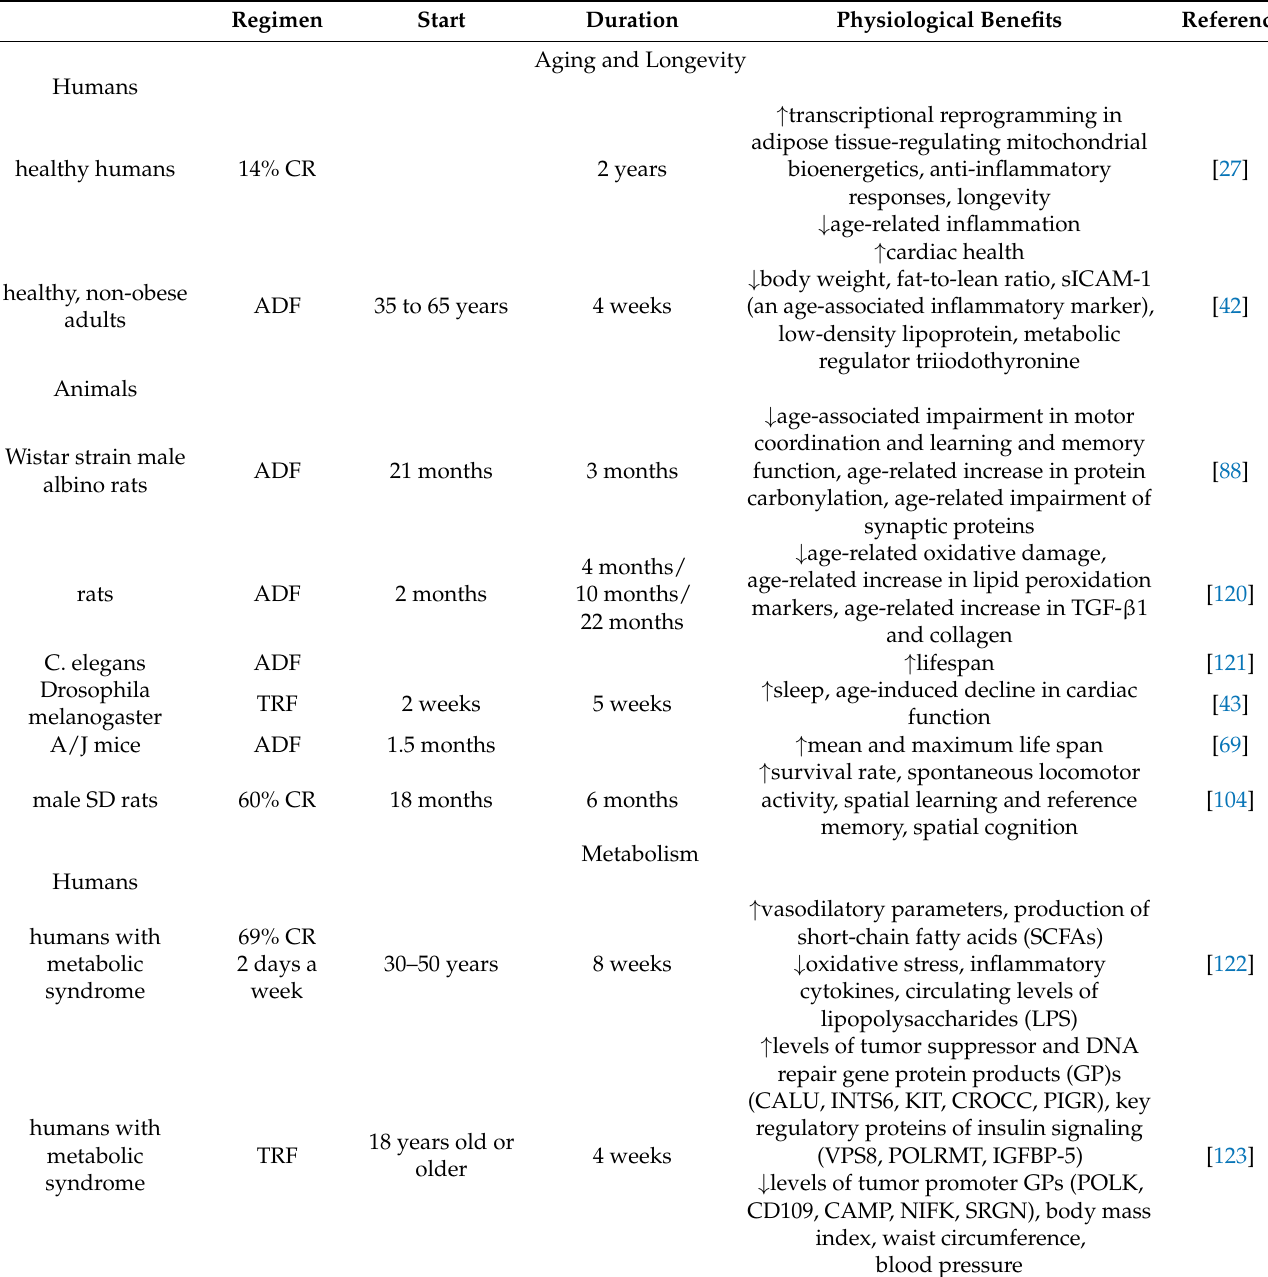
Table 1. The physiological benefits of different types of